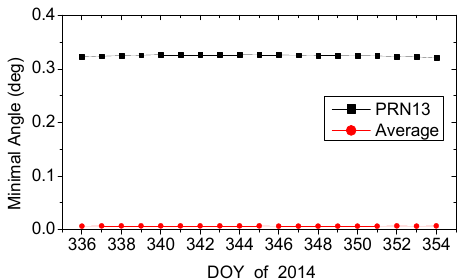
Figure 6. Minimal angle (minimal 0 1 ( , ) t t α value in ARTA) between receiver-to-satellite unit vectors of each two consecutive days from DOY 335 to 354, 2014. The black squares are the minimal angles for PRN 13; each value is a daily average. The red circles are the average minimal angles of all the ( , ) t t α value in ARTA) between receiver-to-satellite unit vectors Figure 6. Minimal angle (minimal Figure 6. Minimal angle (minimal α ( t 0 , t 1 ) value in ARTA) between receiver-to-satellite unit vectors of ( , ) t t α value in ARTA) between receiver-to-satellite unit vectors 0 1 Figure 6. Minimal angle (minimal 0 1 satellites with the repeat time in the normal range. of each two consecutive days from DOY 335 to 354, 2014. The black squares are the minimal angles each two consecutive days from DOY 335 to 354, 2014. The black squares are the minimal angles for of each two consecutive days from DOY 335 to 354, 2014. The black squares are the minimal angles for PRN 13; each value is a daily average. The red circles are the average minimal angles of all the PRN 13; each value is a daily average. The red circles are the average minimal angles of all the satellites for PRN 13; each value is a daily average. The red circles are the average minimal angles of all the satellites with the repeat time in the normal range. with the repeat time in the normal range. satellites with the repeat time in the normal range.